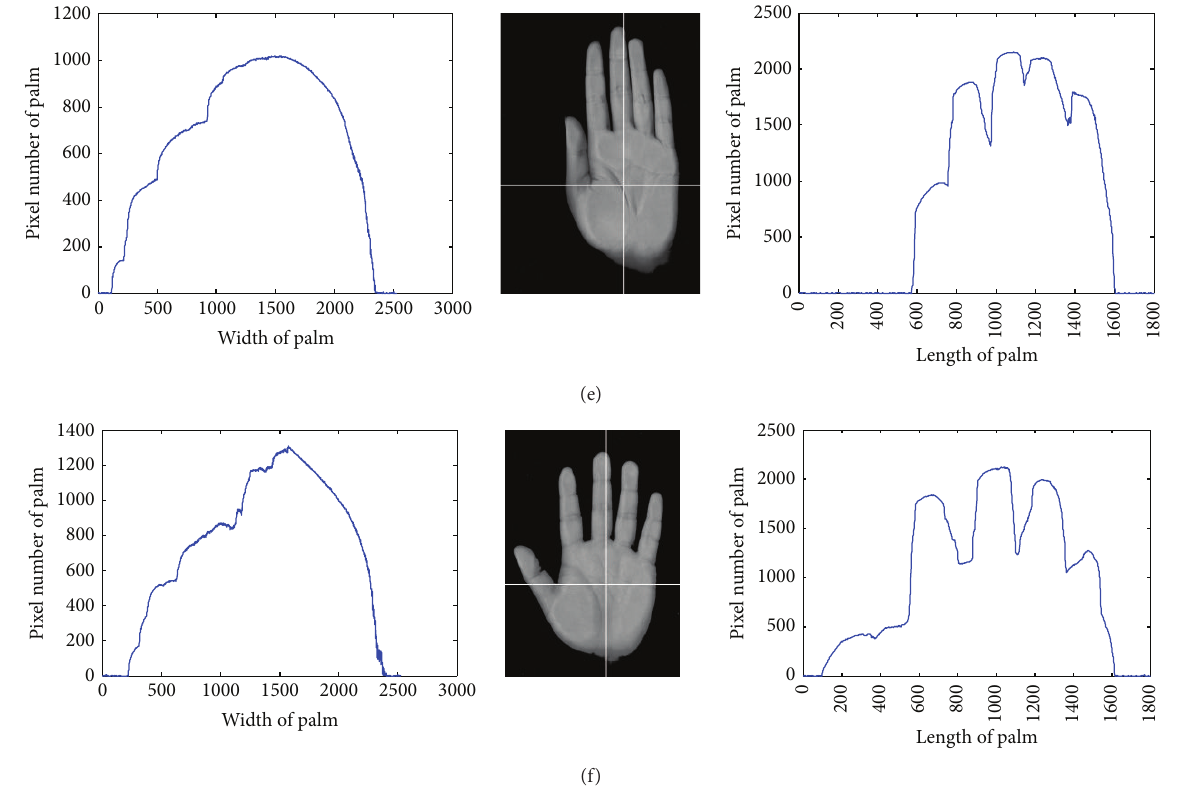
Figure 8: The length and width of palm.